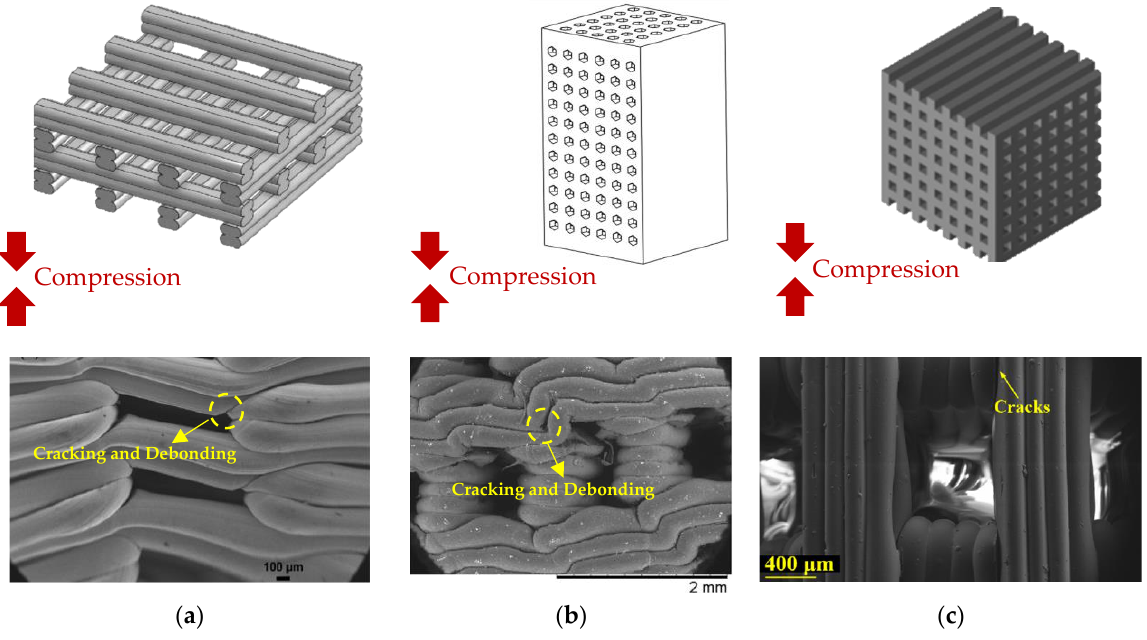
Figure 11. Shearing and debonding of layers in PLA prints subjected to compression fatigue in ( a ) (Adapted with permission from [38]. Copyright 2021, Elsevier) and ( b ) (Adapted with permission from [17]. Copyright 2016, Elsevier) and ( c ) illustration of fatigue cracks at the layers’ interfaces (Adapted with permission from [39]. Copyright 2021, Elsevier). Cyclic compression caused the shear deformation of prints and cracking and debonding at the layers’ interfaces .